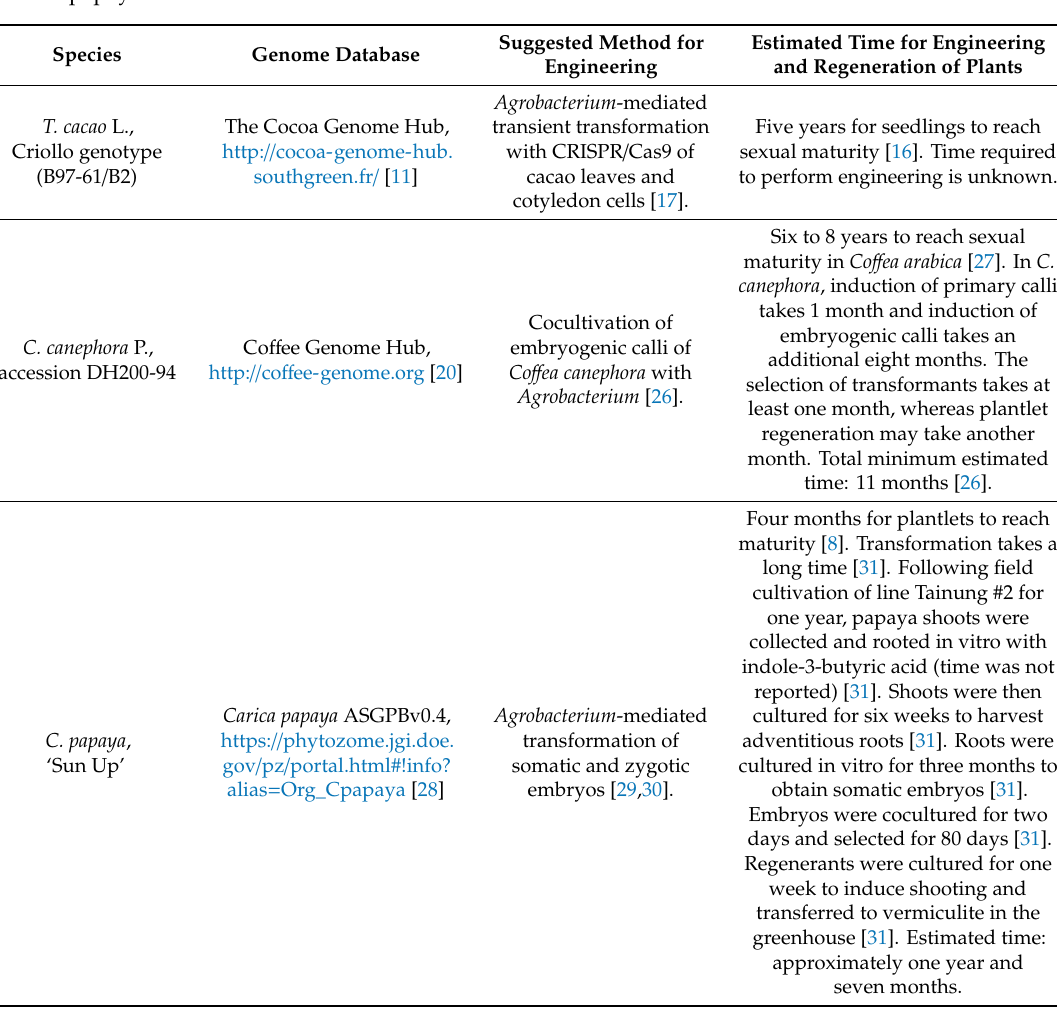
Table 1. Resources and methods for the study and transformation of genomes in cacao, co ff ee, and